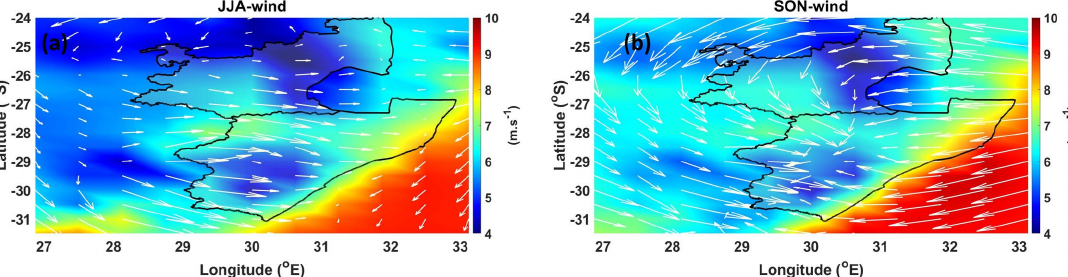
Figure 8. Average wind speed and direction (indicated as arrows) over the MP and KZN region during the ( a ) JJA, and ( b ) SON